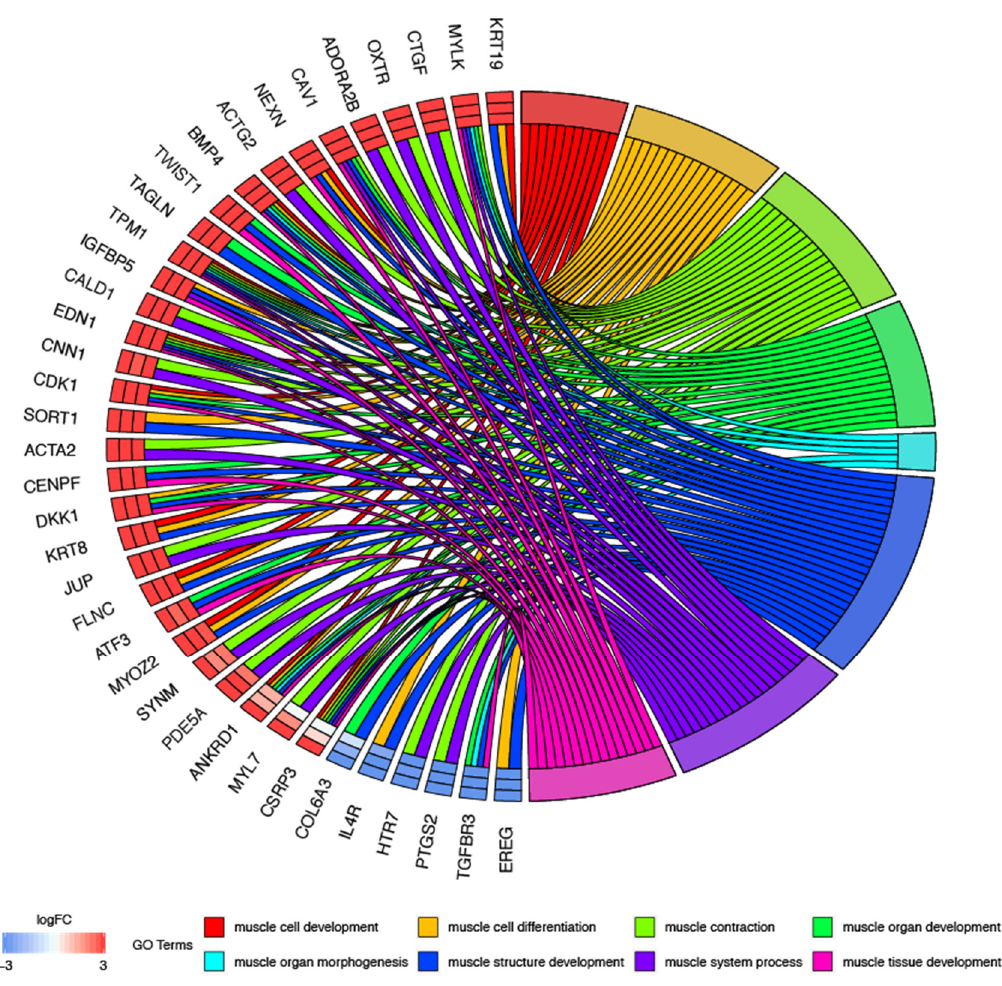
Figure 2. Analysis of enriched gene ontological groups involved in muscle cells morphogenesis, structure, development and differentiation. The network plot presenting the linkages of genes and GO BP terms.